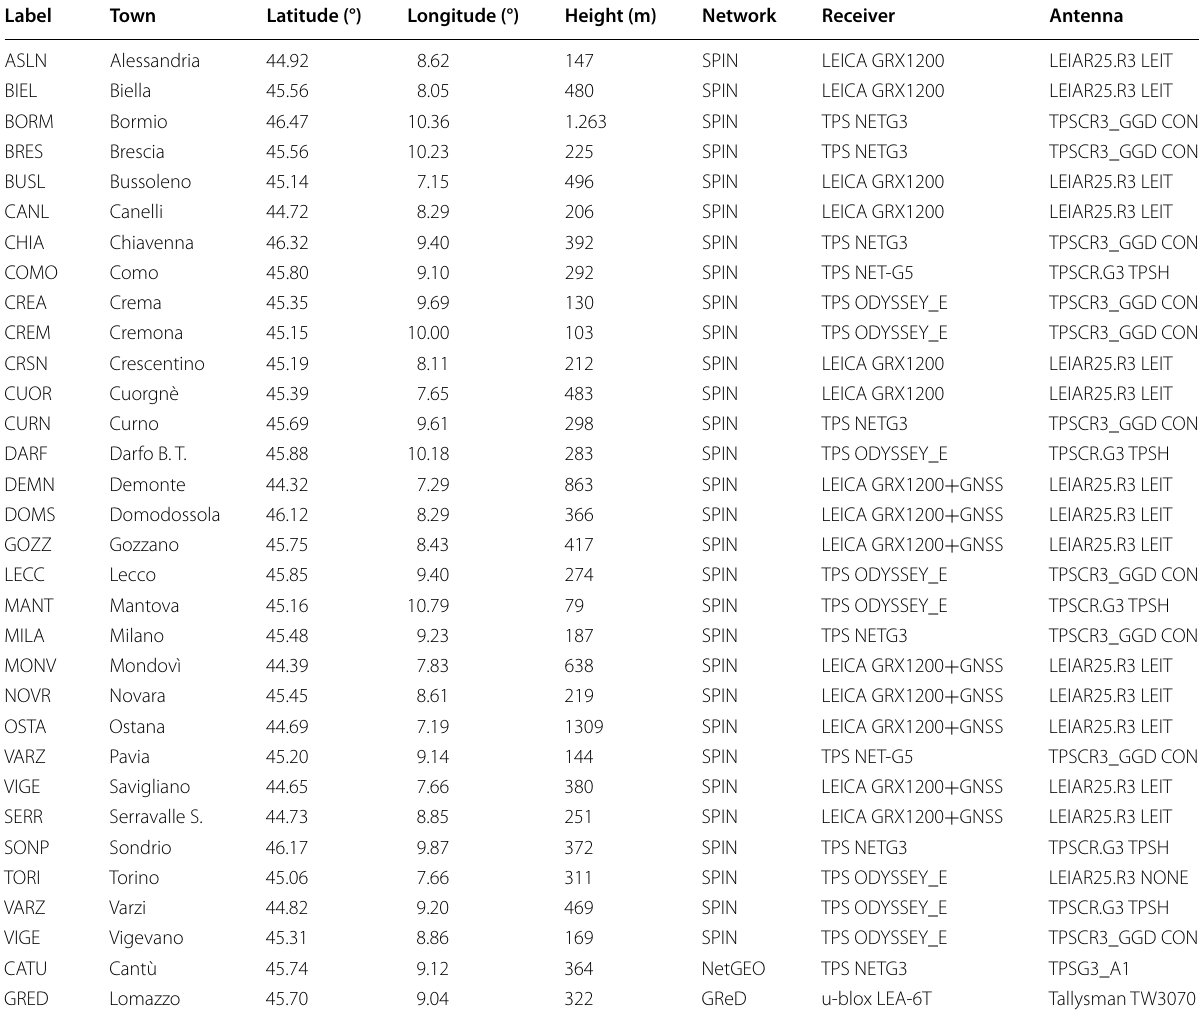
Table 5 Details for the GNSS